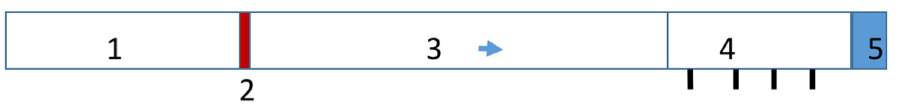
Figure 2. Schematic representation of an ISTRA conventional shock tube experimental setup. Num- bers indicate the main elements of the setup: 1 is the high-pressure chamber; 2 is the destructible copper membrane; 3 is the low-pressure chamber; 4 is the measuring section of the low-pressure chamber containing pressure sensors; 5 is the sample with a test tube containing a solution of HRP enzyme placed at the end of the shock tube.